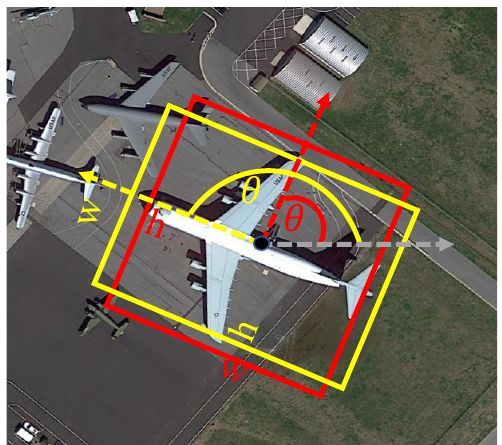
Figure 4. Boundary discontinuity problem of angle prediction. The red and yellow bounding boxes indicate two different targets. Although the two square-like targets have slightly different edge ( w and h ) lengths, there is a huge gap between the angle target θ .